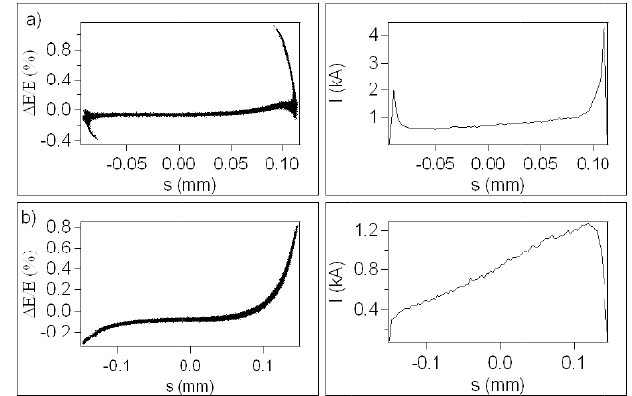
FIG. 7. Longitudinal phase space and peak current distributions: